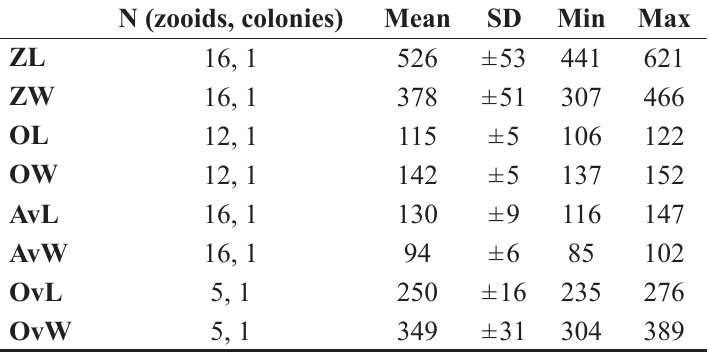
Table 2. Measurements in µm of Microporella tanyae sp. nov., Pliocene, Yorktown Formation, Virginia, USA; holotype NHMUK PI BZ